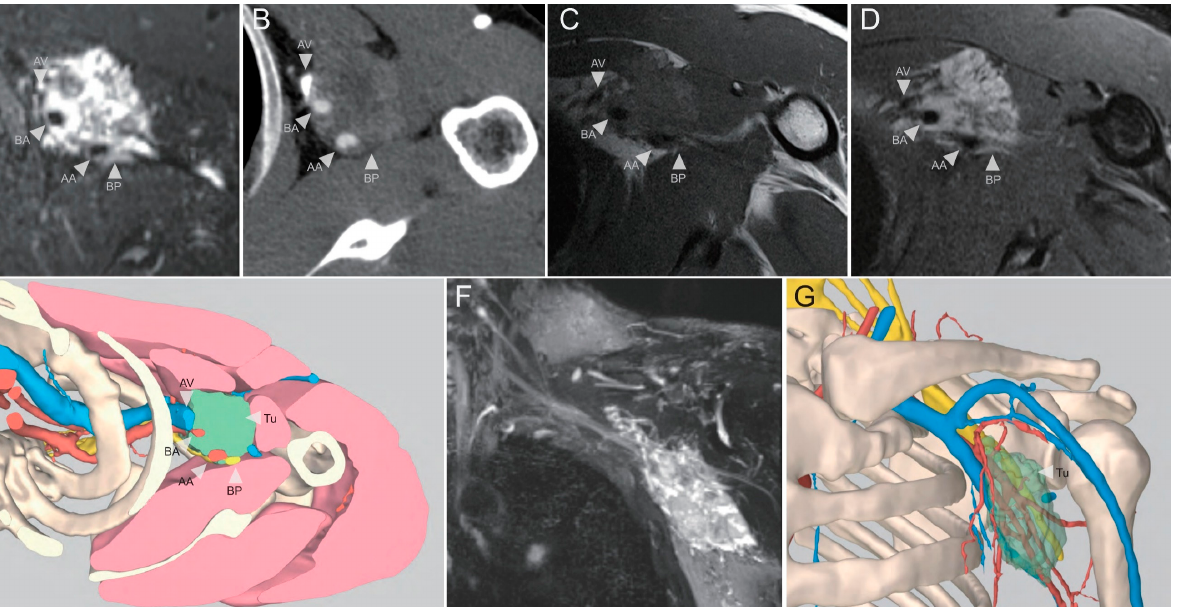
Figure 3. Classic images and their 3D reconstructions in a patient with liposarcoma. ( A ) MR hydrog- raphy image; ( B ) CT angiography image; ( C ) T1-weighted MRI; ( D ) T2-weighted MRI; ( E ) multimo- dality 3D reconstruction image with similar axial views as ( A – D ); ( F ) coronary view of MR hydrog- raphy image; ( G ) anterior view image of multimodality 3D reconstruction. Abbreviations: BA, bra- chial artery; BaV, basilic vein; BV, brachial vein; BP, brachial plexus; Tu, tumour. 2.4. Data Collection and End-Point Selection The patient enrolment period was between November 2019 and December 2020, whereas data collection was from November 2019 to June 2021. Clinical baseline data